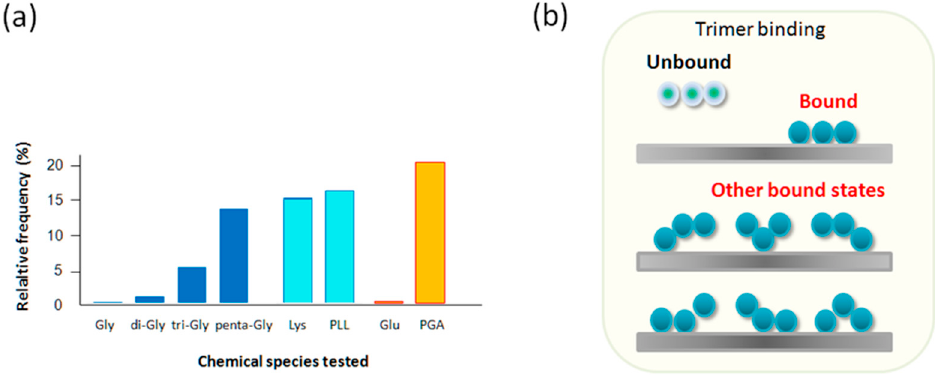
Figure 5. Relative frequency of binding events. ( a ) The relative frequencies of observing force peaks satisfying our criteria were, less than 1%, 3–5%, 7–10%, 10–15% for Gly, di-Gly, tri-Gly, and penta-Gly, respectively. The data on Lys, PLL, Glu, and PGA are also shown indicating enhanced binding of positively charged molecular species for Lys and length dependency for the rest; and, ( b ) schematic explanation on the increased statistical factor for binding of tri-Gly, which is assumed to have three binding sites (including the N-terminal amide) with corresponding number of acceptor sites on pyrite. There are considered to be seven possible bound states with different configurations against on unbound state.